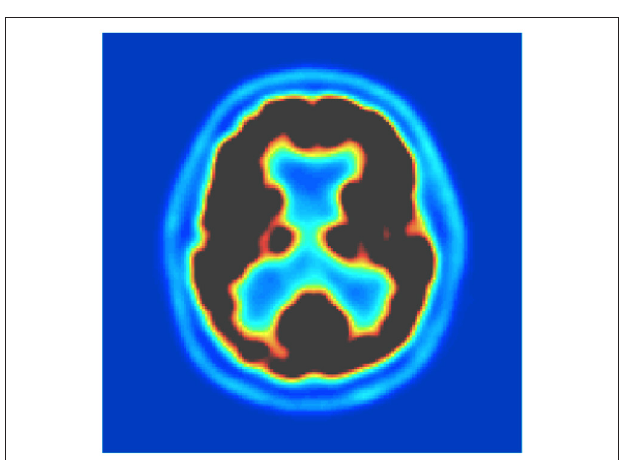
FIGURE 5 | Sample of preprocessed AD images.